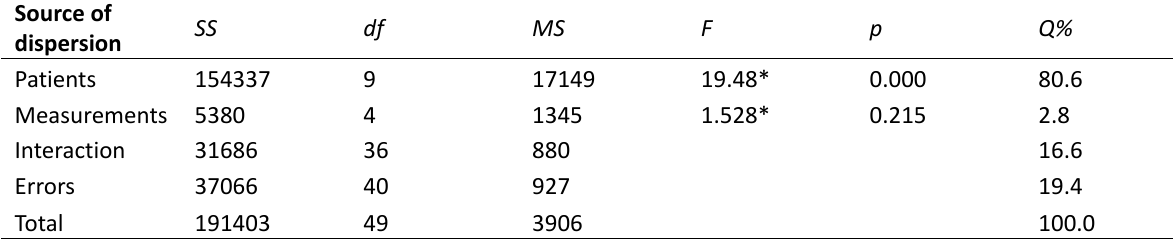
Table 3. Results of two ways ANOVA for repeated measures regarding the A−B feet situation Source of